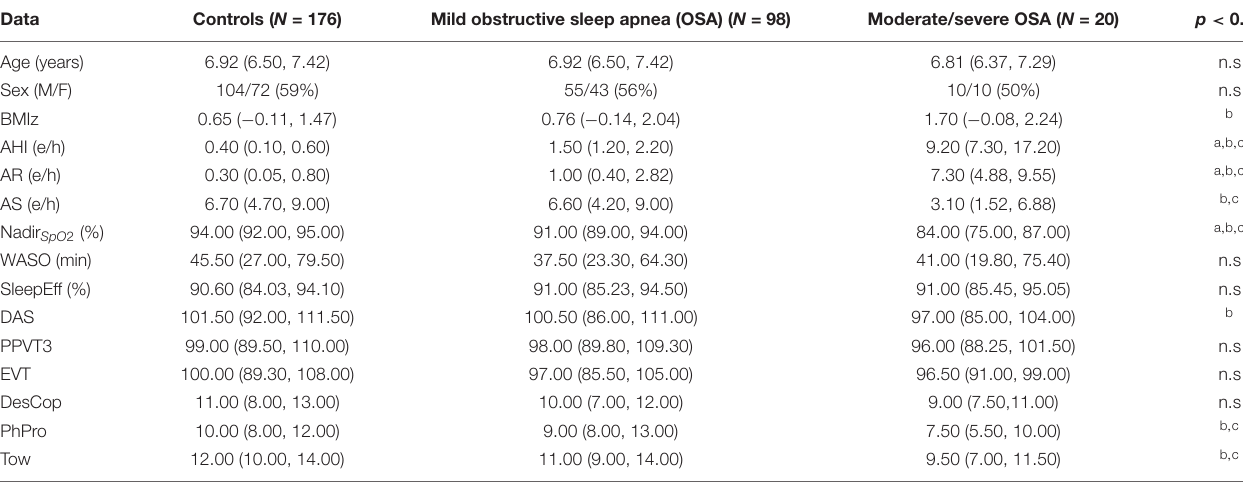
TABLE 1 | Sociodemographic data, polysomnography (PSG) variables, and cognitive scores in the three groups.